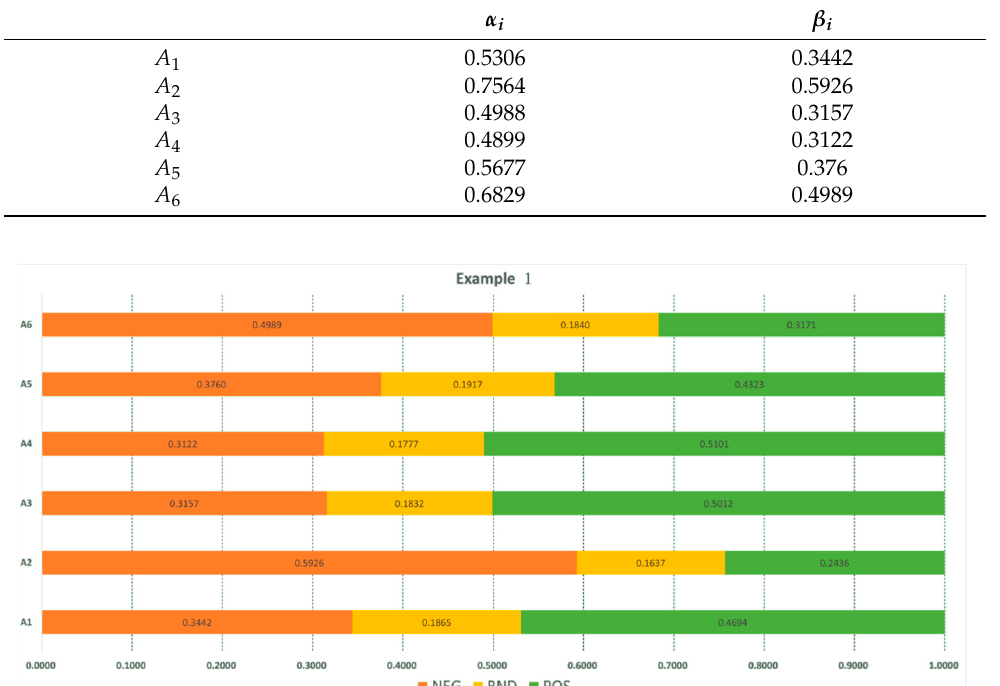
Figure 4. Results of the multi-attribute three-way decisions for Example 1.